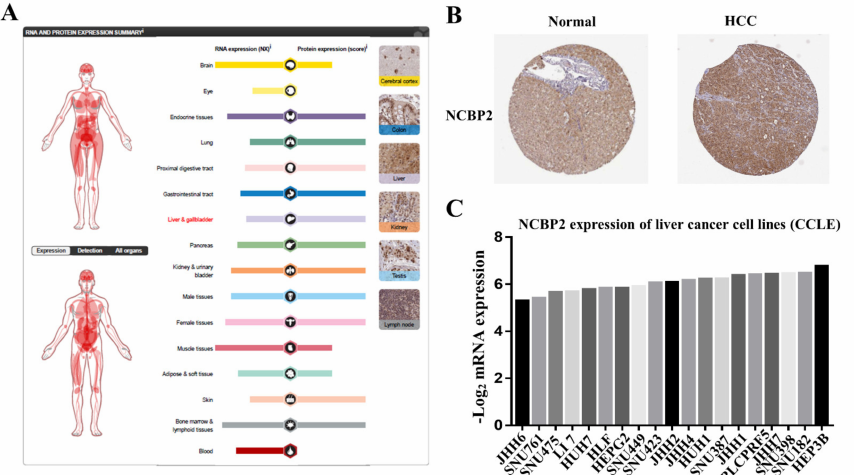
Figure 7. NCBP2 protein expression in human tissues and cell lines. ( A ) NCBP2 protein expression in normal human tissues based on The Human Protein Atlas (THPA). ( B ) NCBP2 expression assessed using immunohistochemistry in normal and liver cancer tissues. ( C ) NCBP2 gene expression profiles of 19 liver cancer cell lines based on Cancer Cell Line Encyclopedia (CCLE)